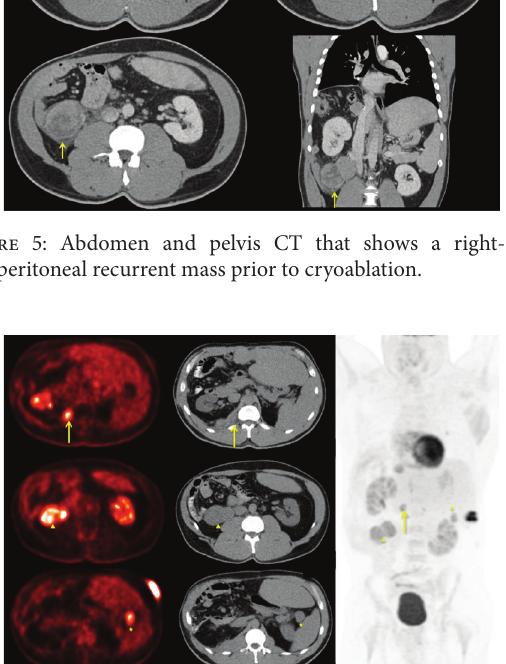
Figure 6: PET scan that demonstrates FDG avidity of omental lymph nodes (stars) and retrocrural lesions (arrows and arrows